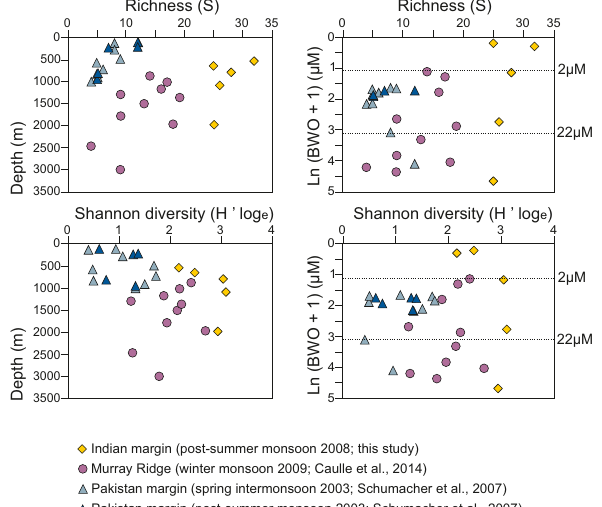
Figure 6. Species richness and Shannon index (calculated for the calcareous fauna only) vs. depth (m) and Ln (BWO + 1) for the In- dian margin, the Pakistan margin and the Murray Ridge. Because some values were <1, the BWO was expressed using the natural logarithm + 1 (Ln(BWO + 1)). The dash lines correspond to the lim- its of the OMZ core (2µM) and to the lower boundary of the OMZ